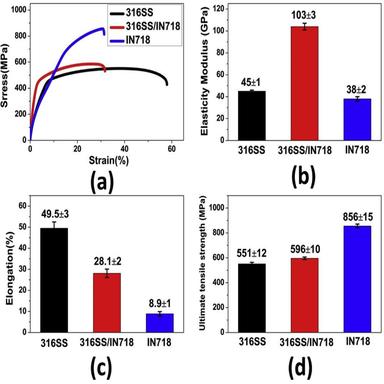
Tensile curves and mechanical properties of 316SS, IN718 and 316SS/IN718/316SS coupons processed by SLM.